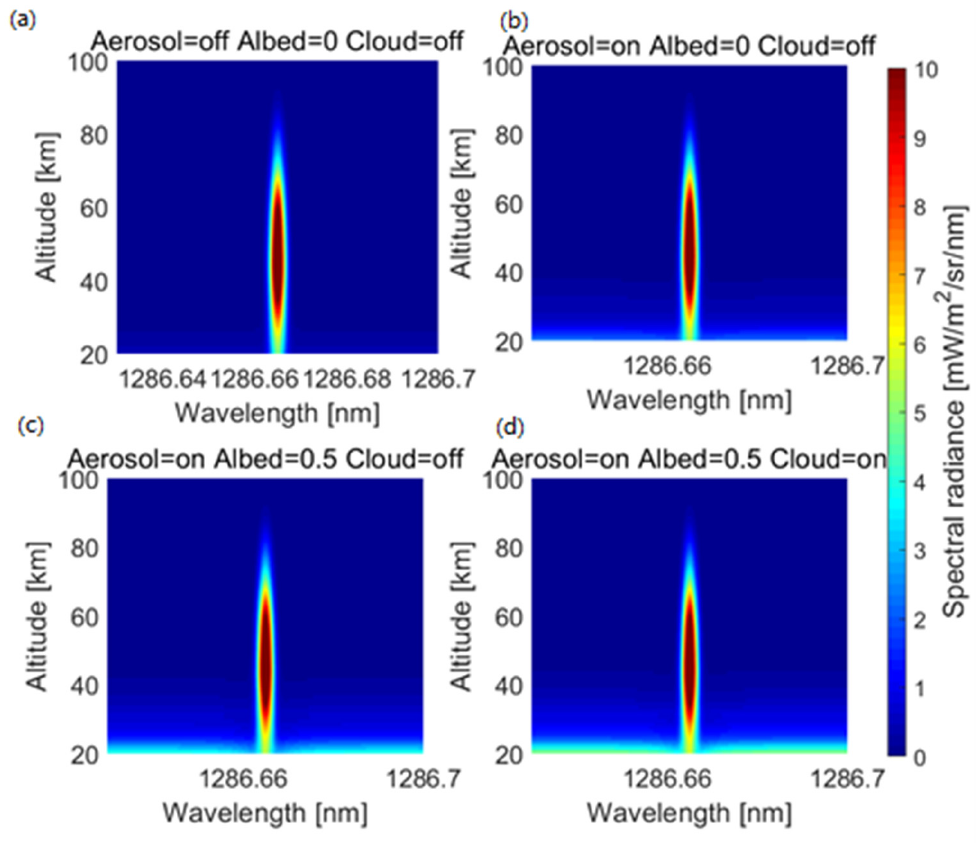
Figure 8. The radiance variations of the O 2 line O 19 P 18 with aerosol, albedo, and cloud at tangent heights from 20 to 100 km.